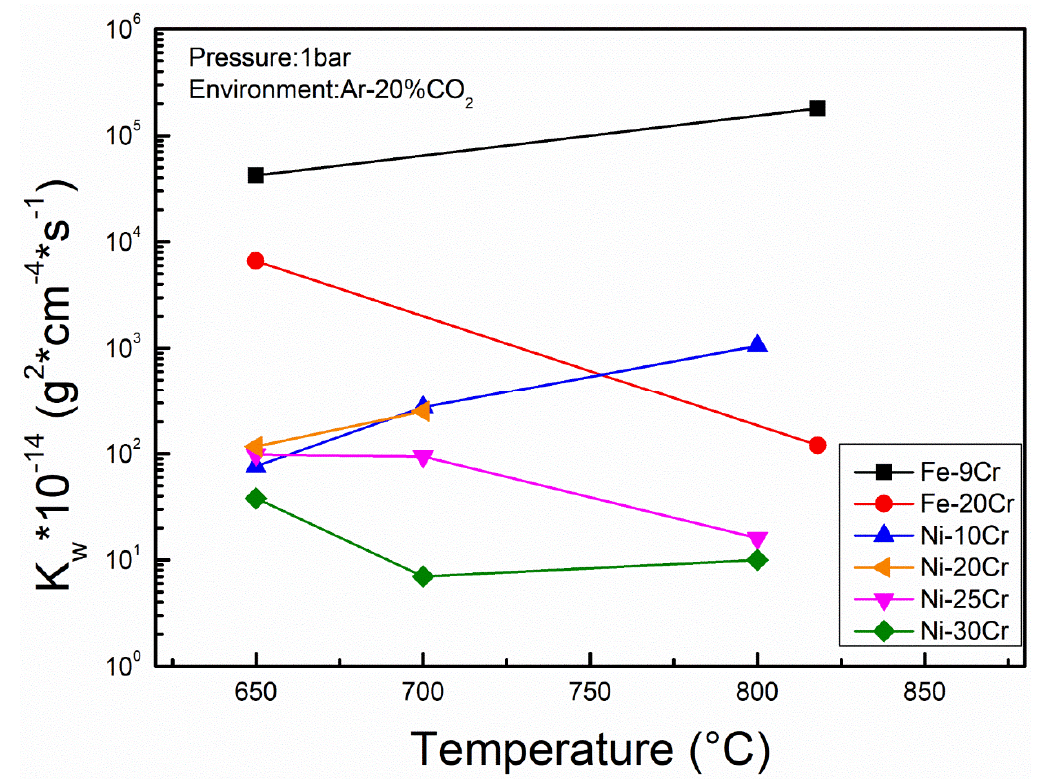
Figure 10. The correlation between the weight gain constant and temperature of Ni–Cr and Fe–Cr binary alloy in Ar-20%CO 2 gas. Data were obtained from references